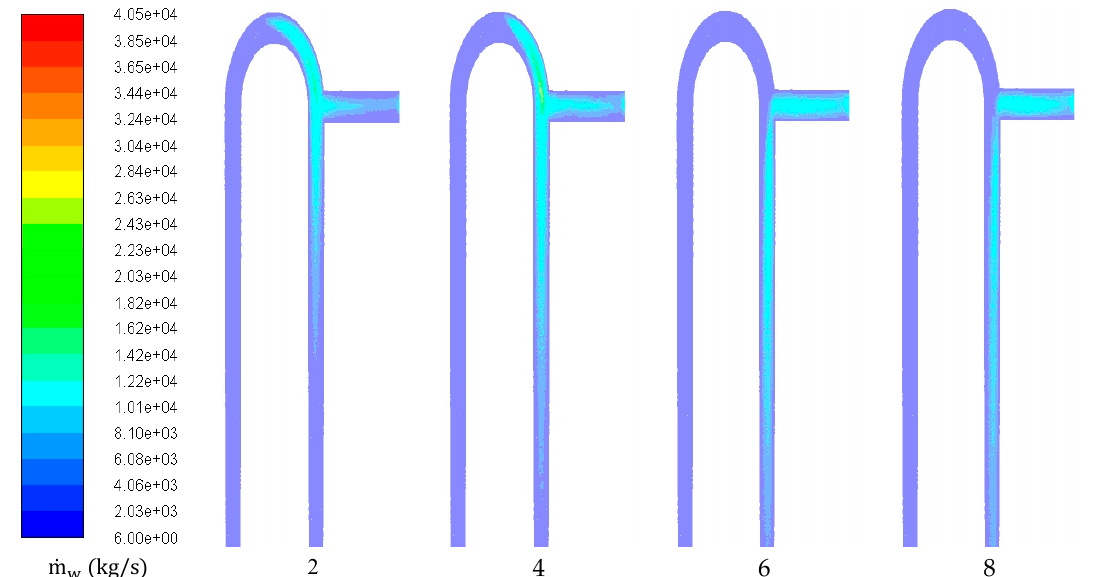
Figure 23. Turbulent Reynolds number contours at di ff erent flow ratios and X w = 4306.59, α m = 0.2 and X v = 0.1.